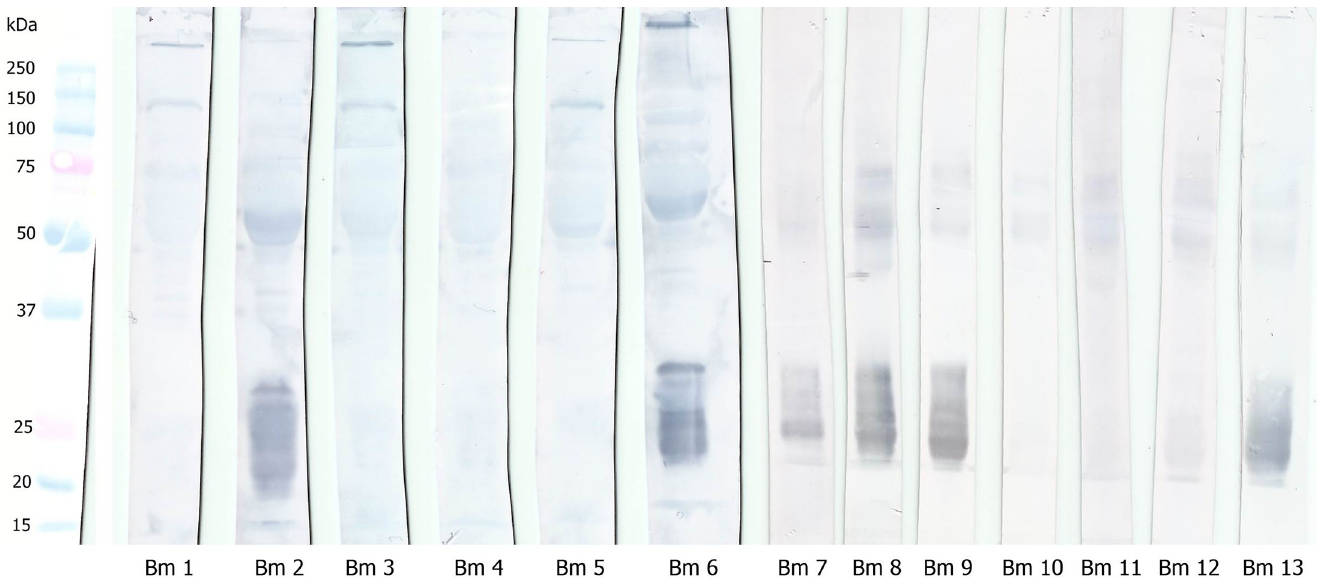
Fig 4. Interaction between B . moojeni plasma and venom proteins evaluated by Western blotting. B . moojeni plasma proteins (20 μ g of protein) were fractionated by SDS-PAGE (10%, under reducing conditions), electrotransferred onto PVDF membranes, and incubated with the respective venom, prior to the incubation step with antibothropic